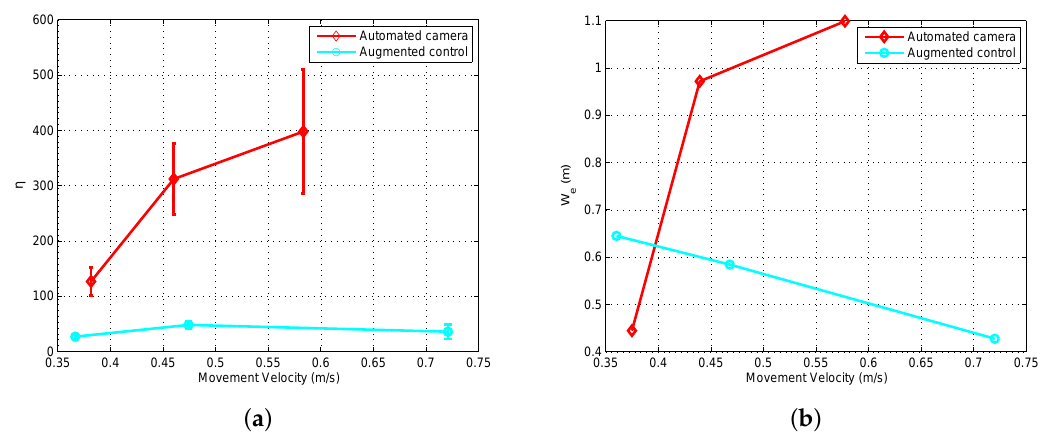
Figure 27. Comparison of the operator workload for different teleoperation configurations. ( a ) Workload versus speed comparison; ( b ) Effective width versus speed comparison.